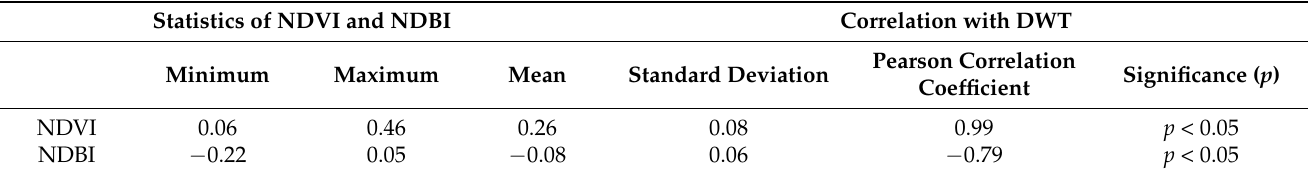
Table 3. Statistics of land-use indices and their correlation with depth to water table